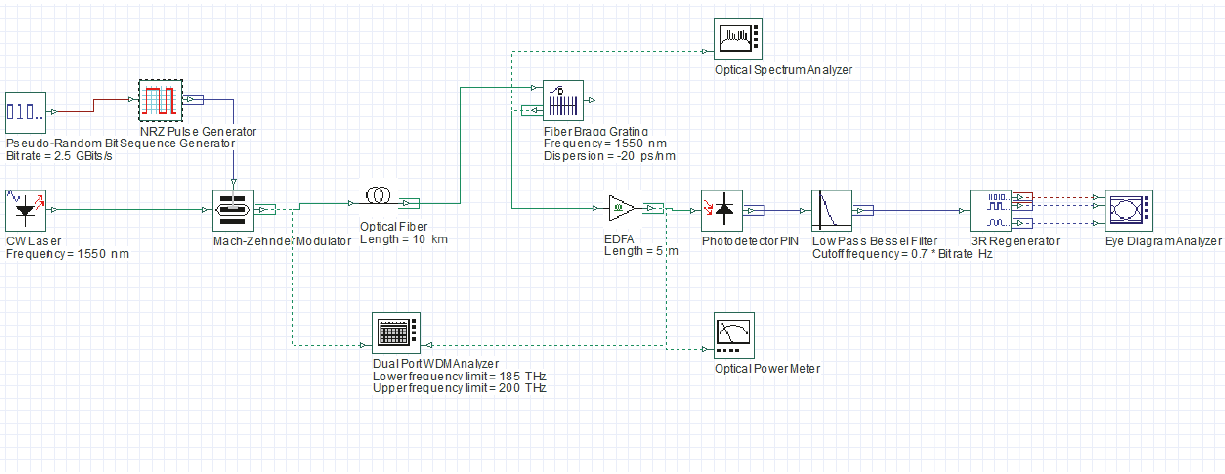
Figure 1: The designed model with one input.